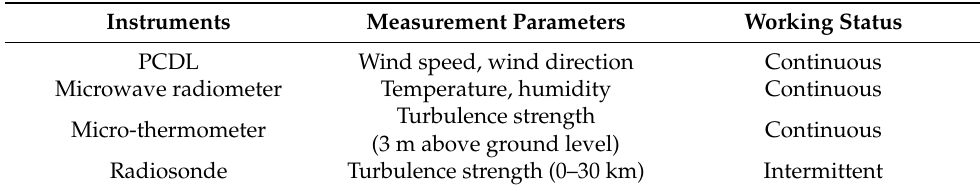
Figure 3. Photographs of ( a ) the micro-thermometer and ( b ) the balloon-borne micro-thermometer. Table 3. Working conditions of the